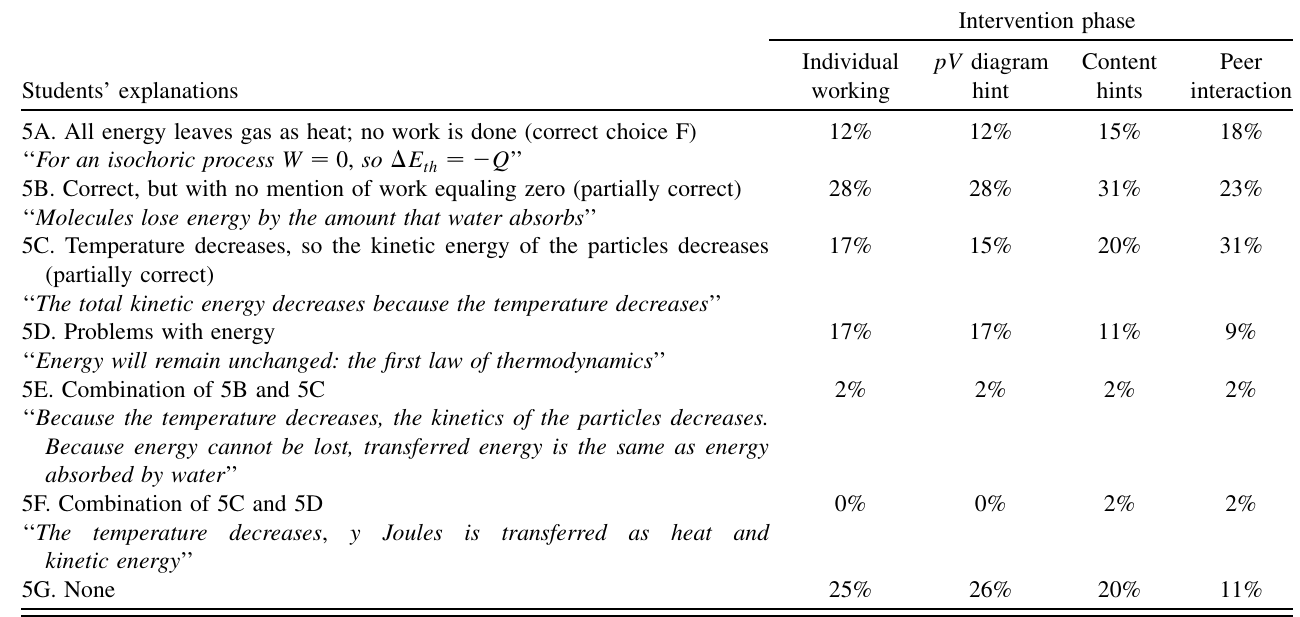
TABLE XI. Students’ categorized explanations regarding heat in an isochoric process. N ¼ 65 . A typical example from each category is presented after the category symbol in